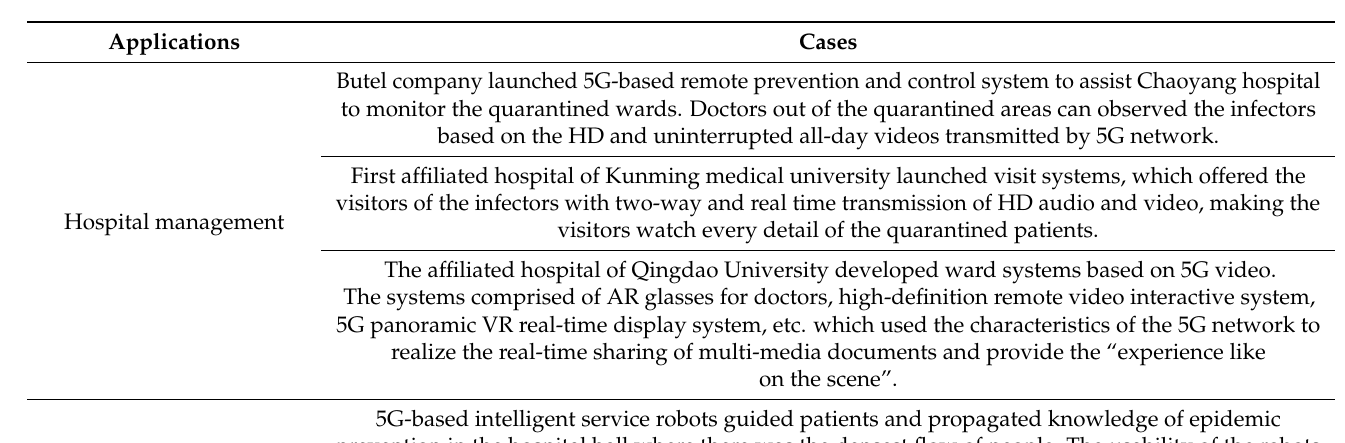
Table 4. The cases in which 5G enabled cutting off the infection